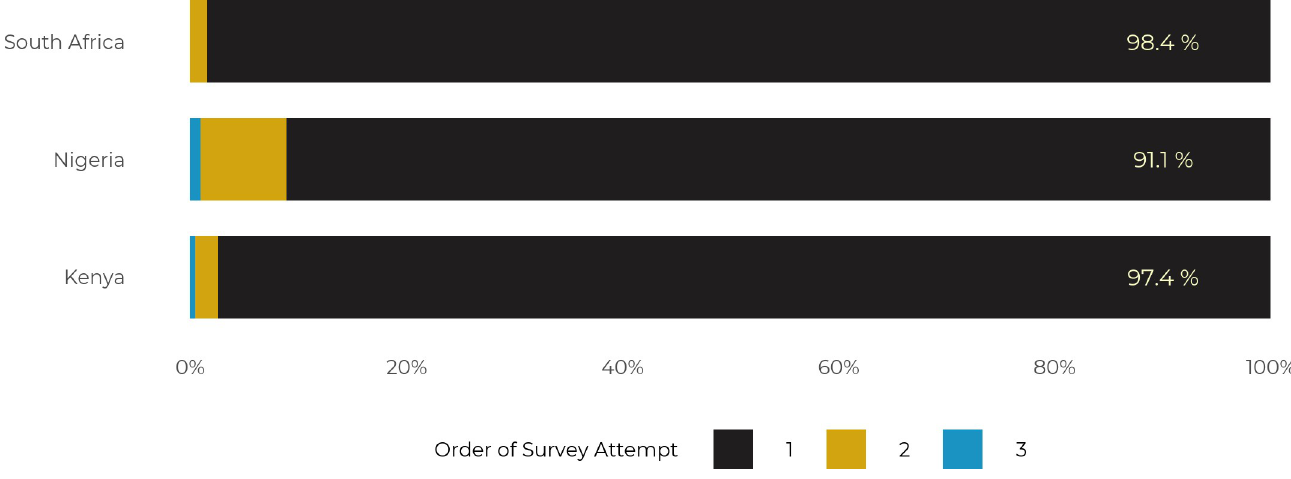
Fig 3. Passage rates across the three attention check